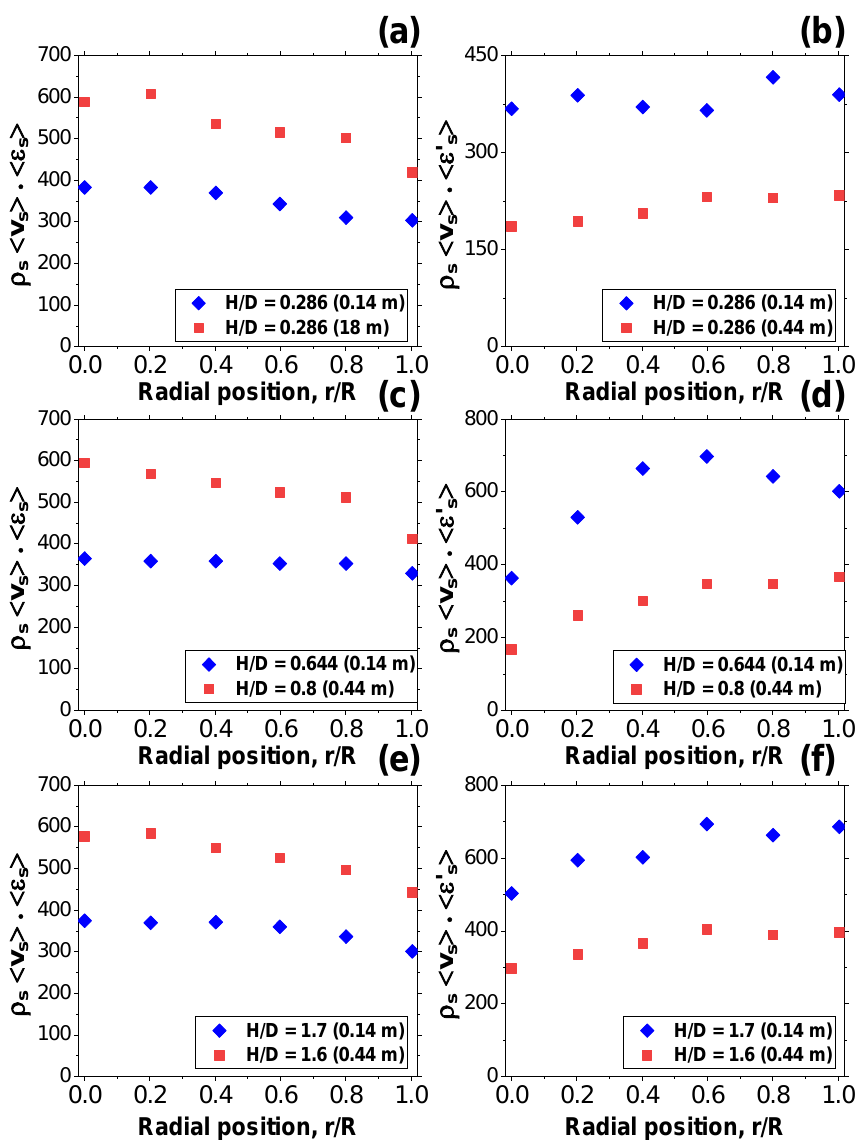
Figure 13. Comparison of the Mass Flux Parameters Profile of Up Flowing Particles for 0.14 m and 0.44 m Fluidized Beds at Different H/D, for Matching Conditions (Case 1 and Case 2). ( a , c , e ) represent the Mass Flux estimation using Equation (11). ( b , d , f ) represent the Mass flux estimation using Equation (12).